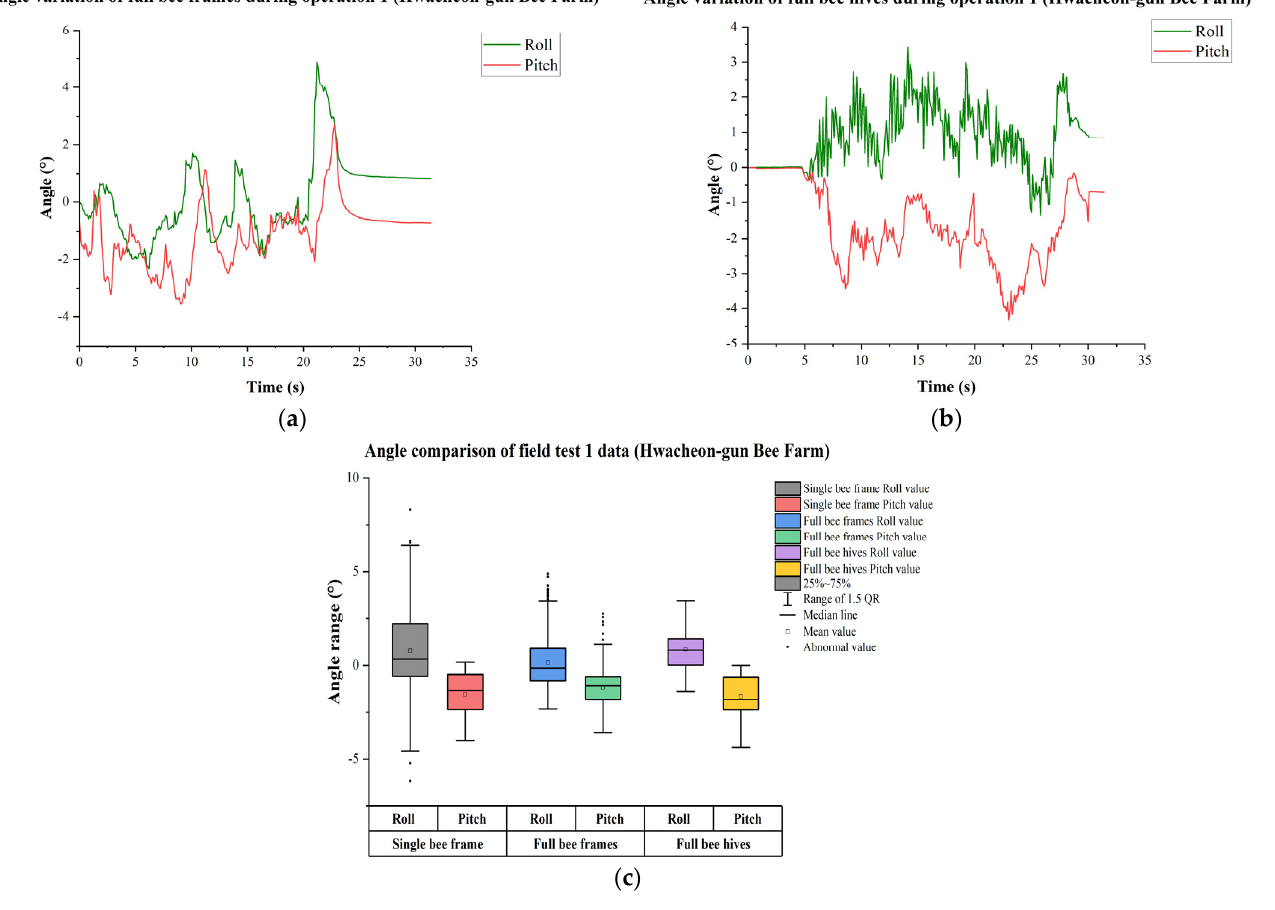
Figure 27. Angle variation of ( a ) the vehicle with a full load of bee frames during s-turn transportation, ( b ) vehicle with a full load of beehives during s-turn transportation, and ( c ) all vehicles during s-turn transportation.